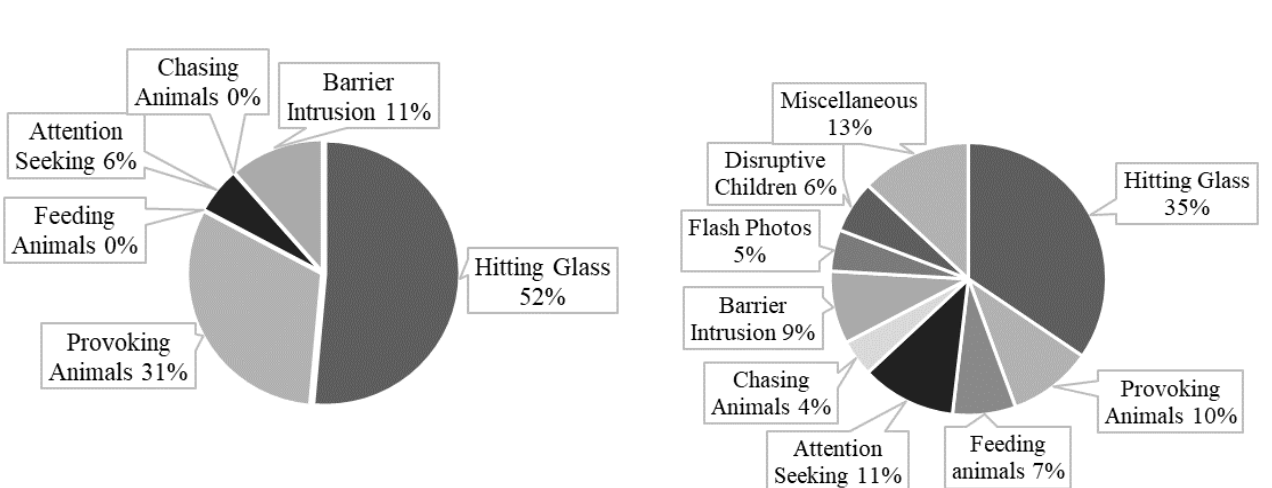
Inappropriate Observed (a) and Reported (b) Behaviors in Zoo Visitors a. Observed Behaviors b. Reported